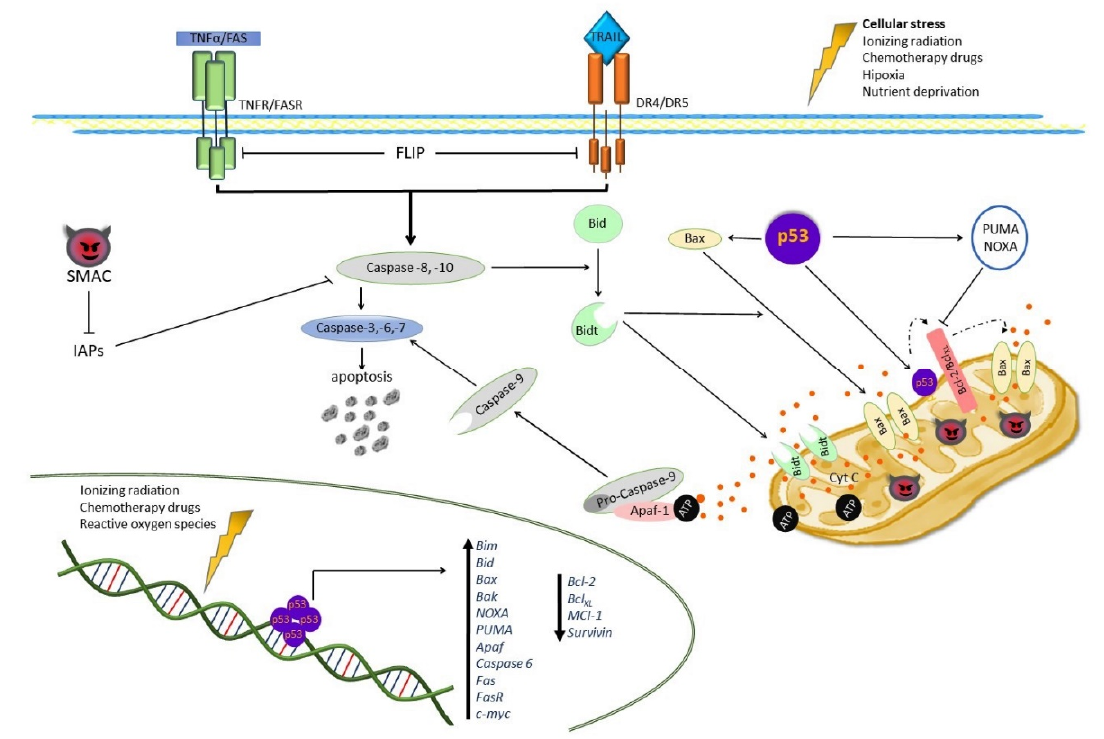
Figure 3. Extrinsic and intrinsic apoptosis pathway and its regulation via p53. Under cellular stress, the extrinsic pathway is started by ligand binding to death receptors, including TNF α , Fas and TRAIL; this leads to the autoactivation of caspases-8 and -10, which in turn promote the catalytic activation of the effector caspase-3. Another target of caspase-8 is the pro-apoptotic protein Bid, which is hydrolyzed to tBid, inducing Bax oligomerization and mitochondria depolarization with release of cyt c. Along with the activation of caspase-9, these events amplify the apoptotic pathway. The intrinsic pathway involves the permeabilization of the mitochondrial external membrane, which facilitates the cytosolic release of pro-apoptotic proteins like SMAC/Diablo and cyt c, which are otherwise confined within the intermembrane space. cyt c binds the Apaf-1 protein, which in turn binds and activates caspase-9, responsible for the activation of apoptosis executioners: Caspases-3, -6, and -7. On the other hand, SMAC/Diablo inhibits IAPs, which bind and neutralize caspases-8 and -10. Another protein involved in apoptosis regulation is p53, which transcriptionally activates pro-apoptotic genes and inhibits anti-apoptotic genes, directly inhibiting Bcl XL and Bcl-2 in the mitochondria, favoring apoptosis. Continue arrows ( ↓ ) indicate activation, arrows with ( ⊥ ) indicate inhibition.